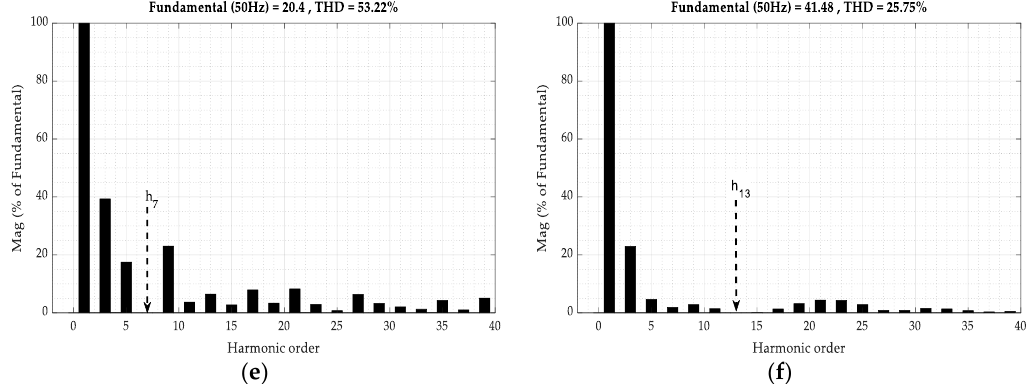
Figure 8. Results of the second case study performances at V DC1 = 20 V , V DC2 = 14 V , and x = 0.7 , in which the seventh and 13th harmonic orders are removed and the fundamental component is controlled by applying a step change in MI from 0.6 to 1.22 at 0.035 s: ( a ) α 1 and α 2 , ( b ) V U and V L , ( c ) resulting output voltage, ( d ) controller output signal, and ( e )–( f ) output voltage spectra.